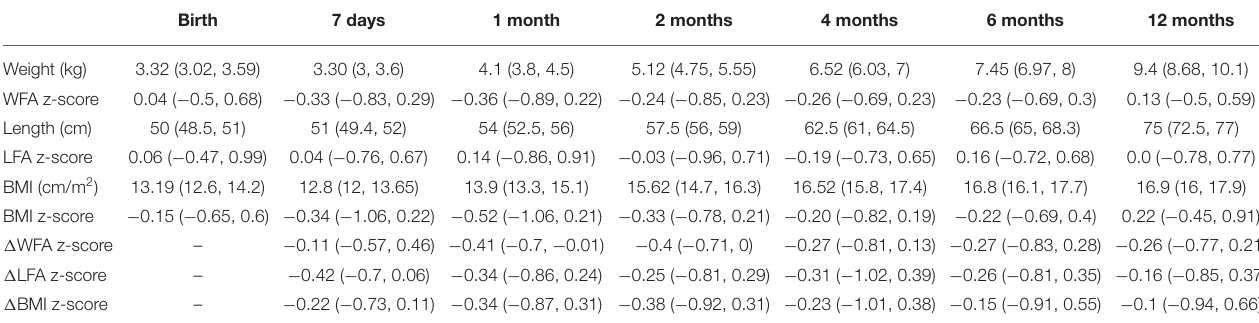
TABLE 2 | Anthropometric measurements of infants ( n = 111) of the study cohort from birth to 12 months of follow-up, expressed as median values and 1st and 3rd quartiles.